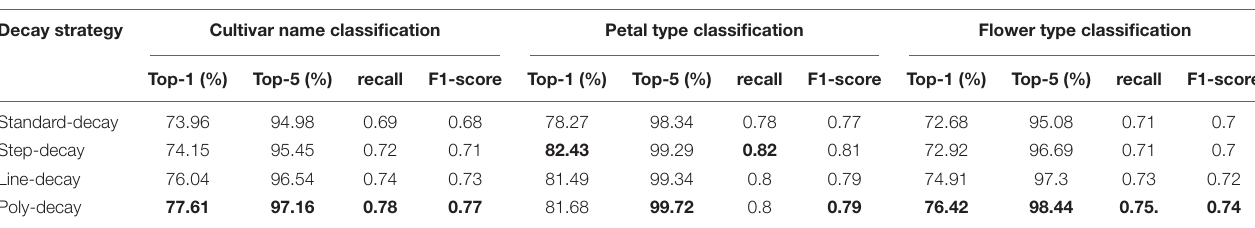
TABLE 1 | Comparison of decay strategy performance in the validation